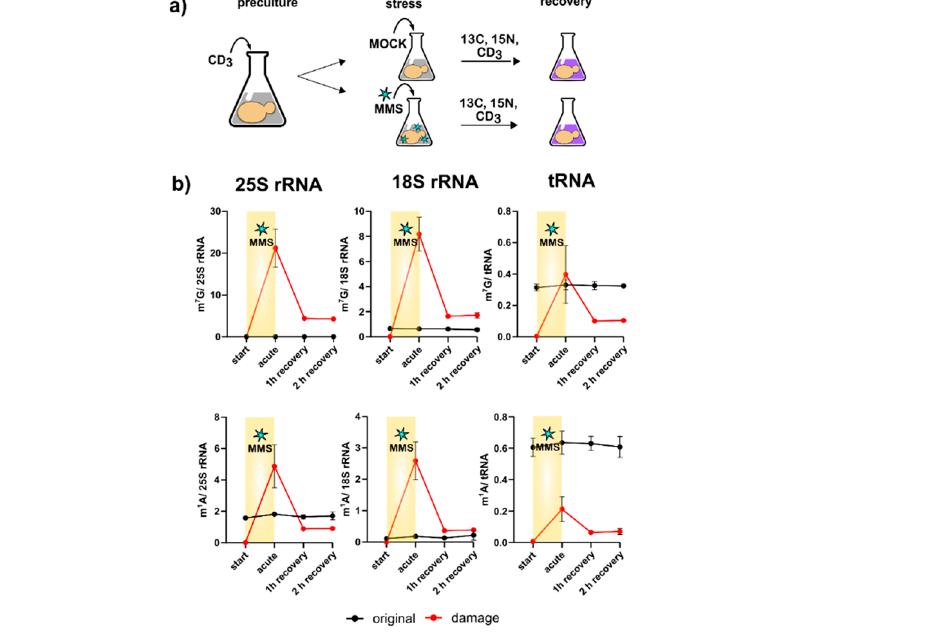
Figure 4. Methylome discrimination-based pulse chase experiment. ( a ) A concept sketch of the assay. Initially cells are grown in a medium containing L-methionine-[ 2 H 3 ]-methyl; after stress exposure the cells are cultivated in medium with L-methionine-[ 2 H 3 ]-methyl and 15 N 2 -uracil, 13 C 6 -glucose. ( b ) Numbers of m 7 G (upper panel) and m 1 A (lower panel) per respective RNA. Red line shows damage-induced methylation; black line shows enzymatic methylation. Data for tRNA from three biological replicates; error bars represent standard deviations. Data for 25S and 18S rRNA from two biological replicates; error bars represent standard deviations.